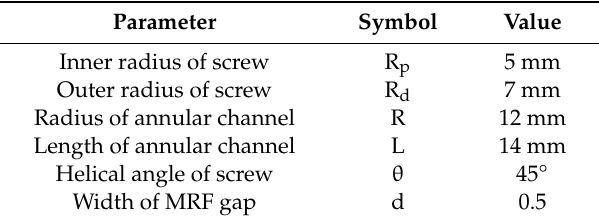
Table 3. Proposed rotary MR damper